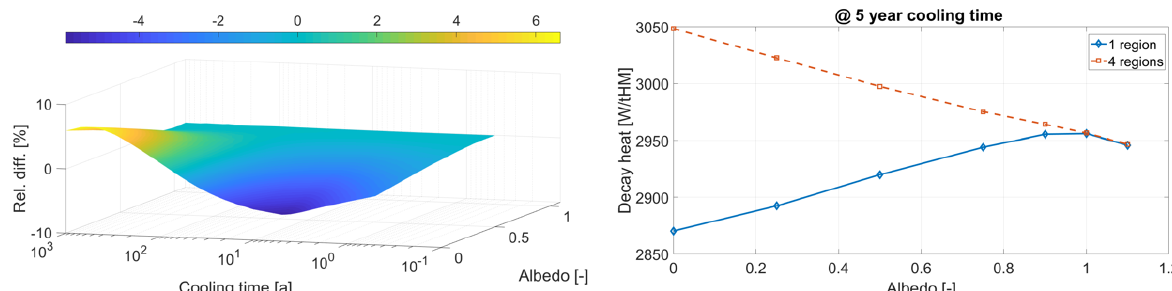
Figure 7. Differences in decay heat rate between 1 region and 4 region cases as a function of albedo and cooling time.